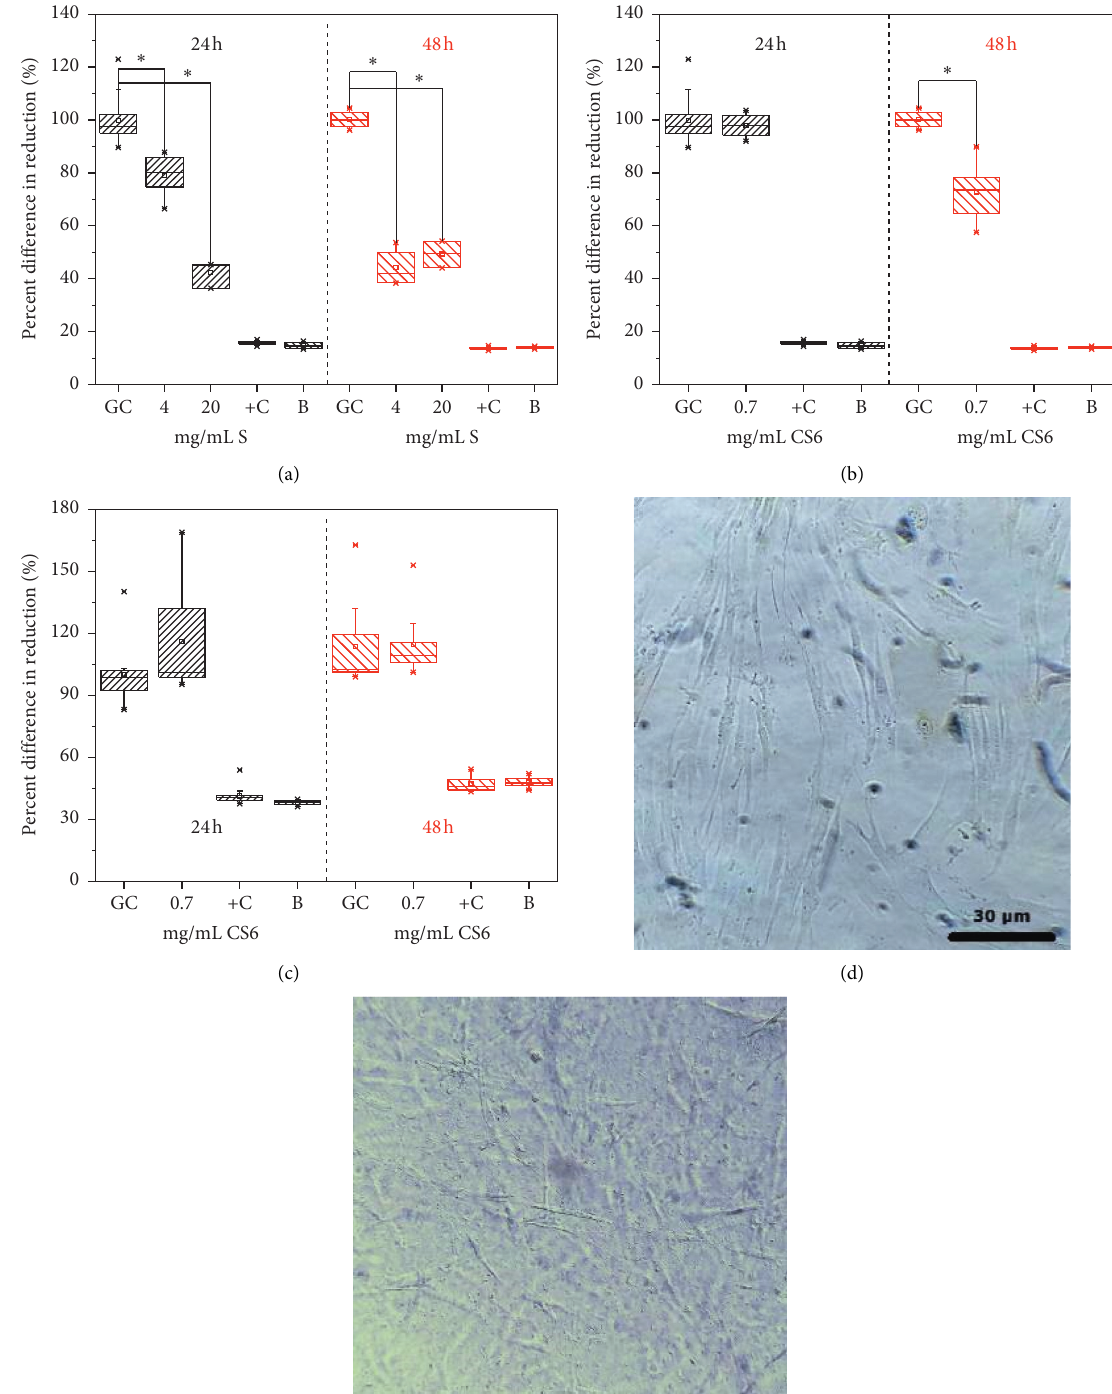
Figure 5: S and CS materials’ cytotoxicity on human fibroblasts. 4 and 20mg/mL S (a) and 0.7 mg/mL CS6 in 2D (b) and 3D (c) human fibroblasts culture. Growth controls: GC, positive controls: +C, and Blanks: B. ∗ Different at a significance level of 0.005, n � 3. (d),